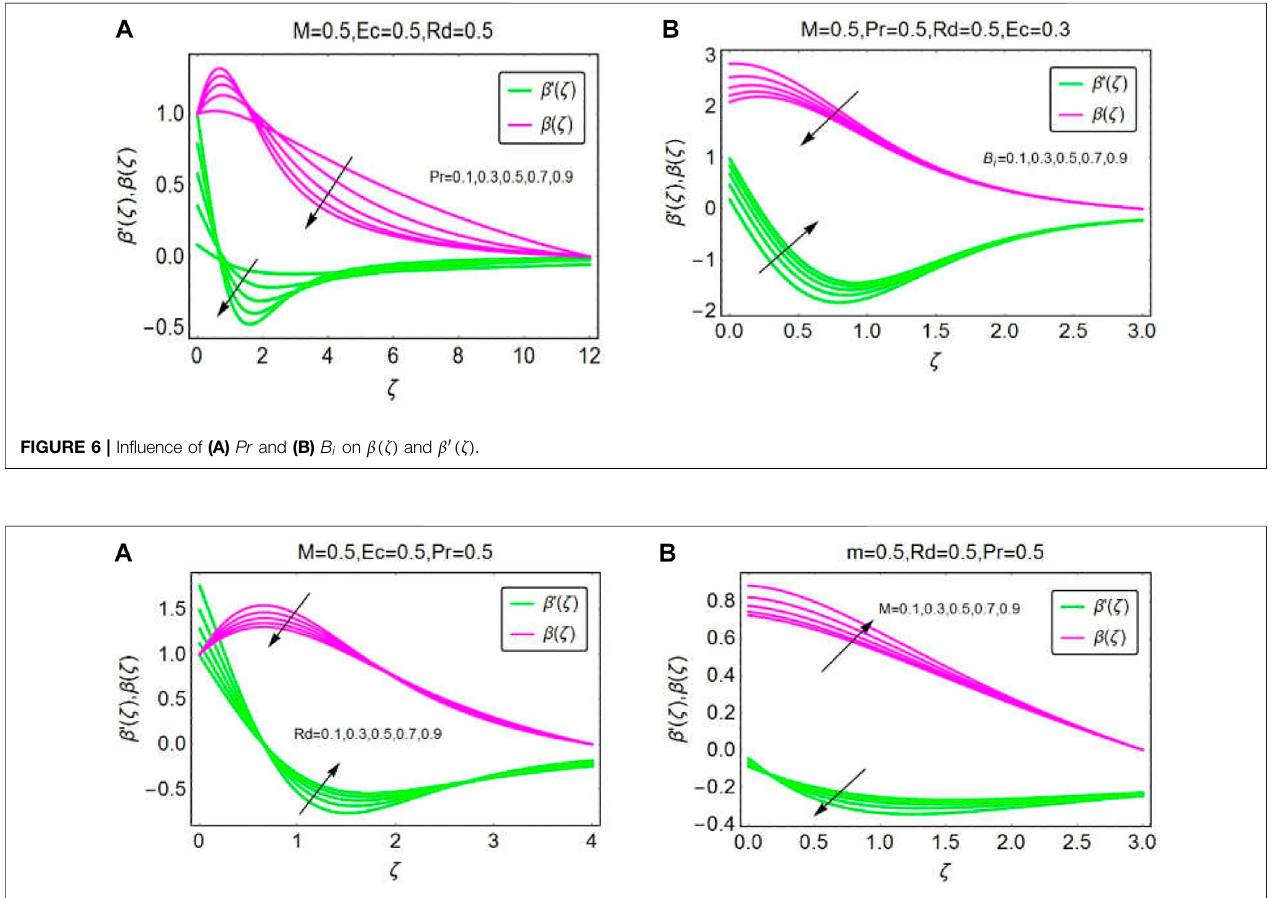
FIGURE 7 | In fl uence of (A) Rd and (B) M on β ( ζ ) and β ′ ( ζ ) .